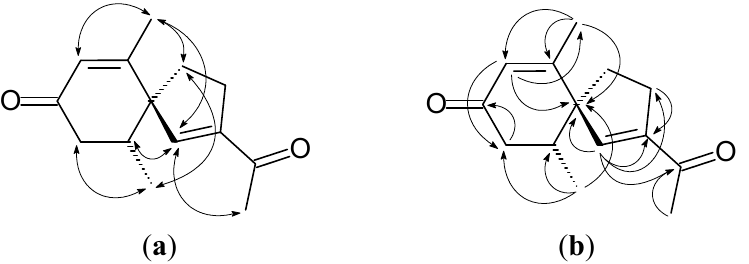
Figure 2. Key NOESY contacts ( a ) and HMBC connectivities ( b ) of compound 1